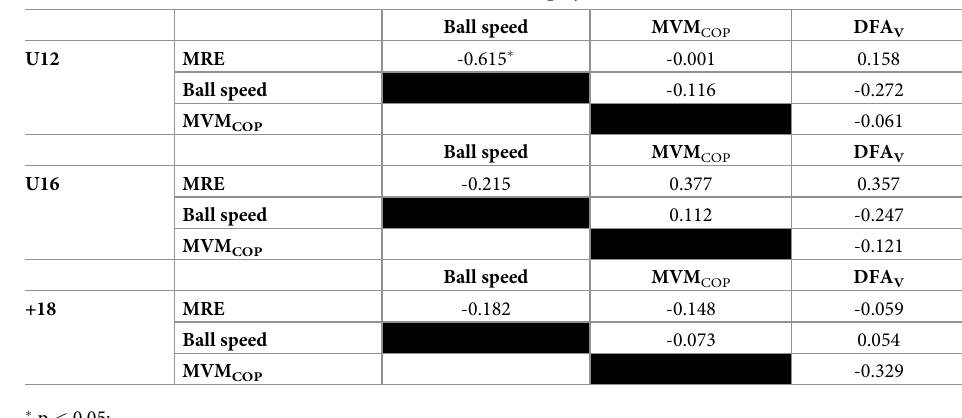
bold font is used for all the significant